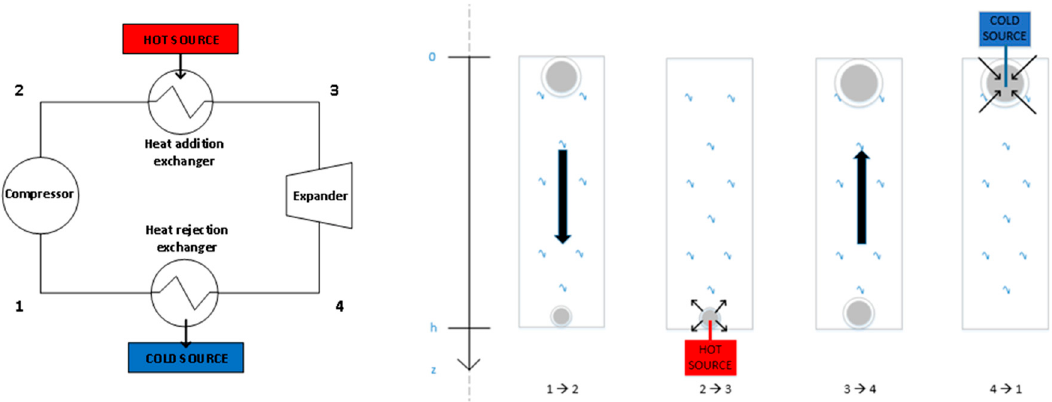
Figure 2. Description of a classic cycle ( left ) and a thermogravitational cycle ( right ). 1 → 2: adiabatic compression, 2 → 3: hot heat transfer, 3 → 4: adiabatic expansion, 4 → 1: cold heat transfer. The left hand